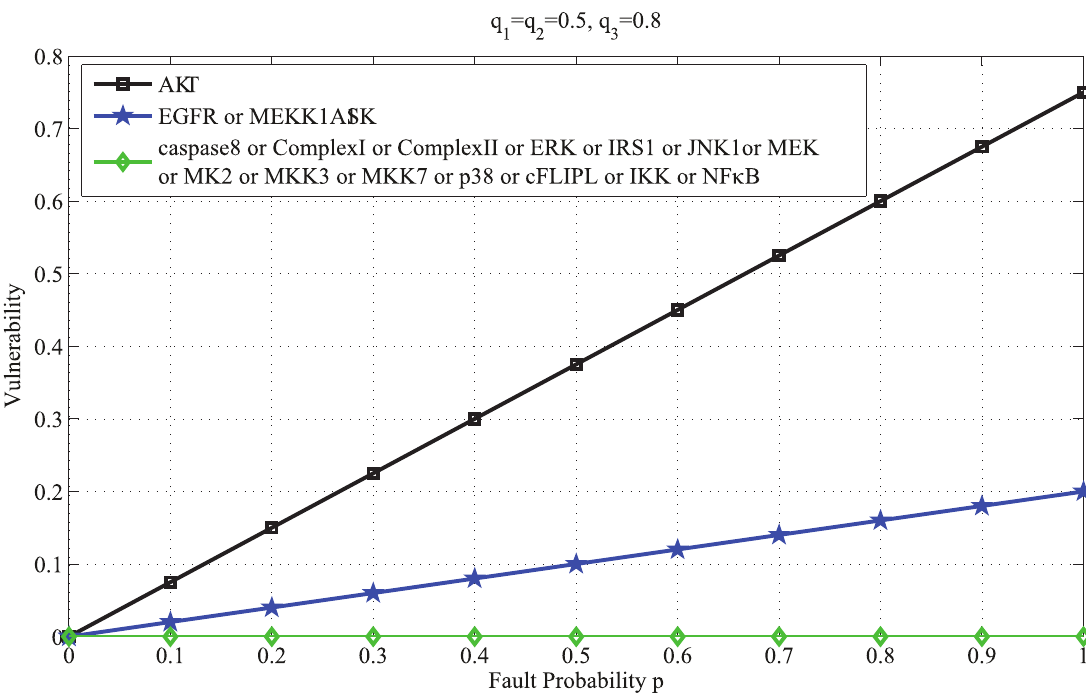
Figure 9. Vulnerability versus the fault probability p for all the molecules in the caspase3 network, while TNF activity is high. Here TNF activity is 0.8, whereas EGF and insulin activities are fixed at 0.5. We observe that the vulnerability of AKT rapidly increases with p , whereas the vulnerabilities of other molecules are zero, except for EGFR and MEKK1ASK1. Due to the increased activity of TNF, these two molecules show some level of vulnerability, which was not present when TNF activity was low.